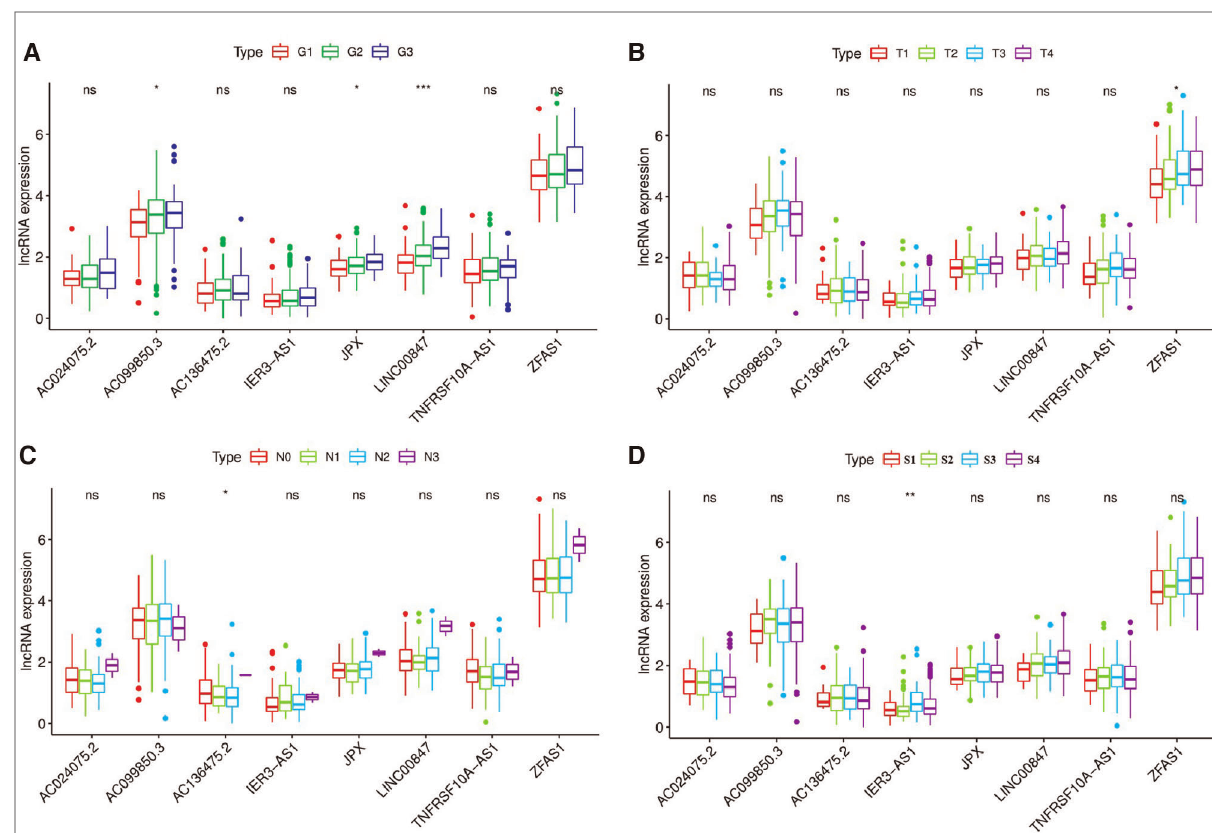
FIGURE 10 Relationship between the expression levels of eight pyroptosis-related lncRNAs and the clinicopathological characteristics of patients with OSCC. ( A ) JPX ( P <0.05), AC099850.3 ( P <0.05) and LINC00847 ( P <0.001) were signi fi cantly correlated with the pathological grade of OSCC patients. ( B ) ZFAS1 ( P <0.05) was signi fi cantly correlated with T stage of OSCC patients ( C ) AC136475.2 ( P <0.05) was signi fi cantly correlated with N stage of OSCC patients. ( D ) IER3-AS1 ( P <0.01) was signi fi cantly correlated with clinical stage of OSCC patients. G1, well differentiated; G2, moderately differentiated; G3, poorly differentiated; G4, undifferentiated; T, T stage; N, N stage; S, TNM synthesis stage; S1, fi rst stage; S2, second stage; S3, third stage; S4, fourth stage. * P <0.05; ** P <0.01; *** P <0.001; ns, not signi fi